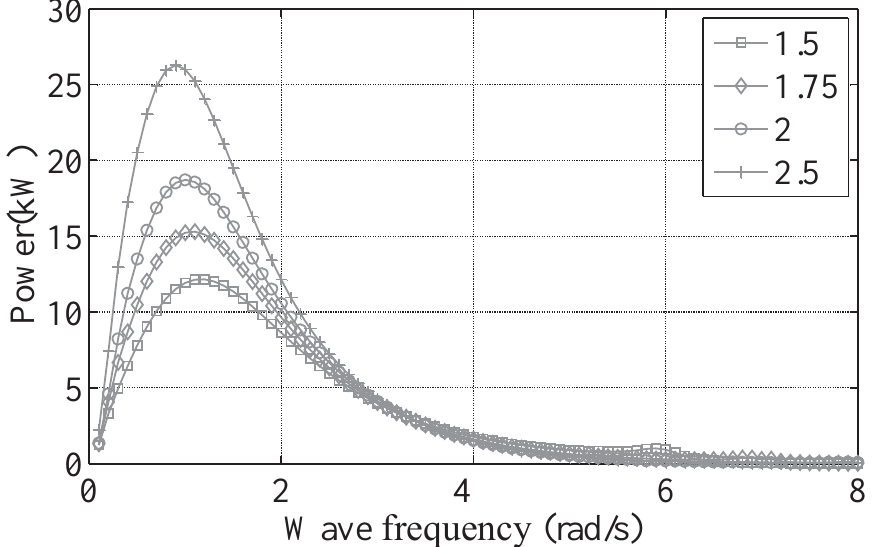
Figure 4. Absorbed power studied in the frequency domain as a function of wave oscillating velocity, shown for four different buoy sizes and at there corresponding optimum γ . Optimum values of γ were 57 kNs/m, 86 kNs/m, 124 kNs/m and 218 kNs/m, for the buoys with radii 1.5 m, 1.75 m, 2 m and 2.5 m